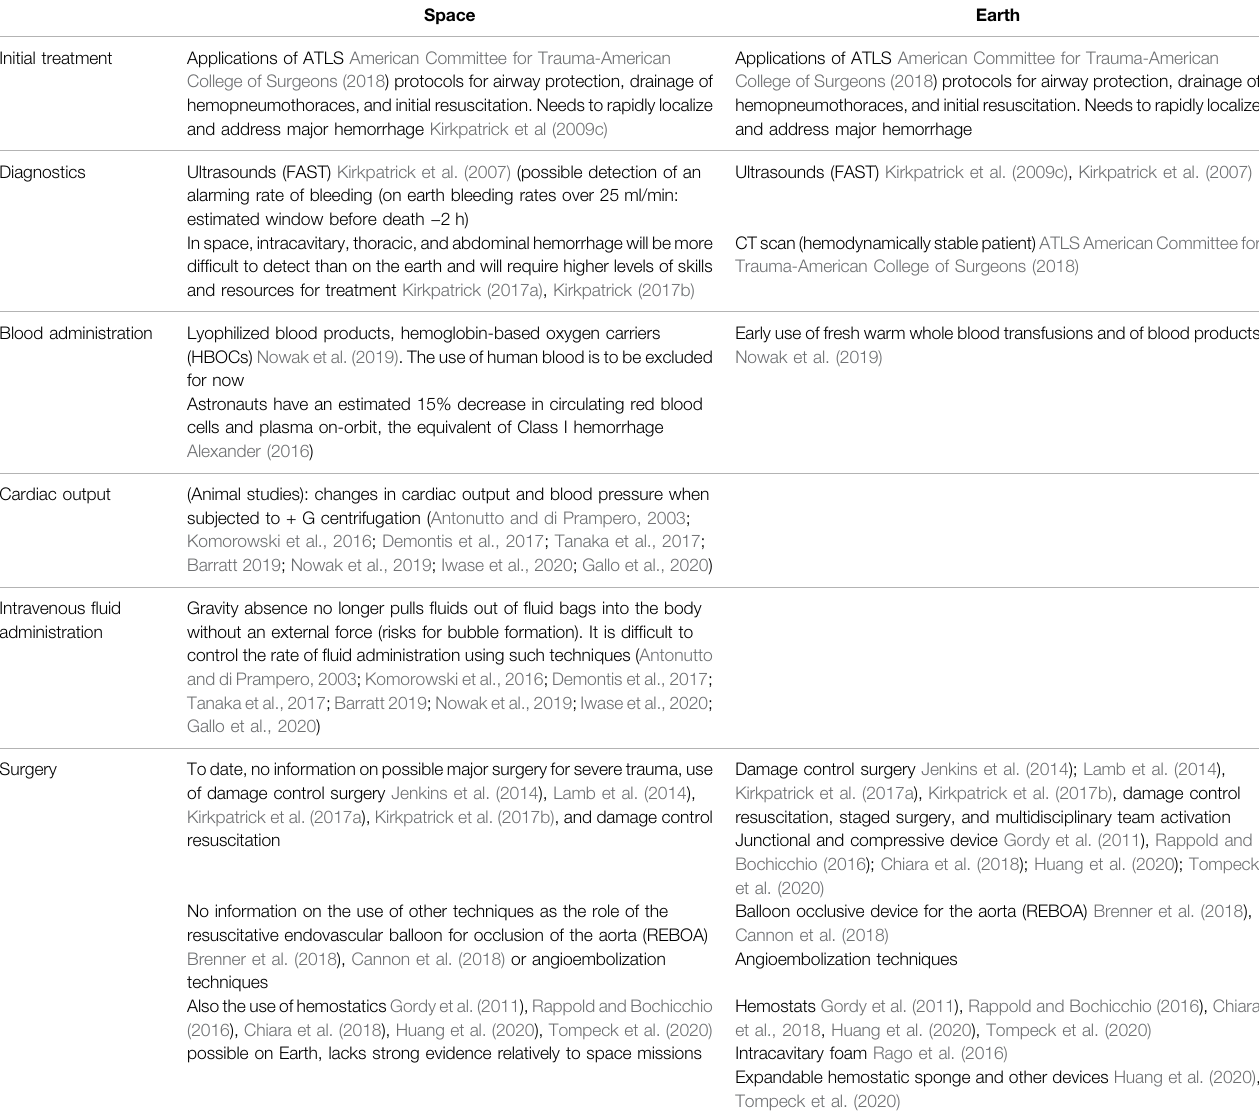
TABLE 2 | Approach to hemorrhage control in space and on Earth. Research studies conducted on the ISS (Neurolab Missions). Space Earth Initial